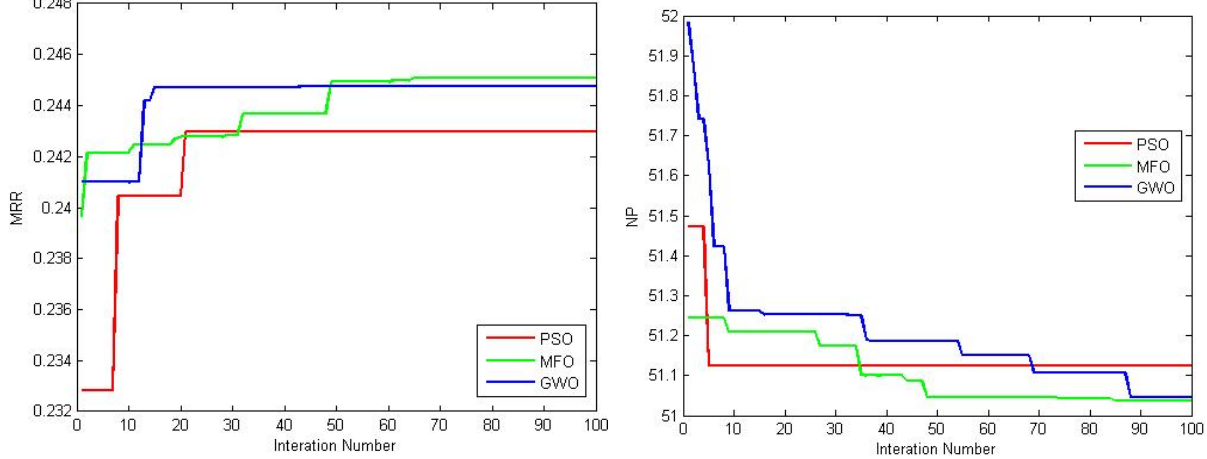
Figure 15. Comparison of convergence plots for various algorithms for MRR and NP. The optimum process parameters obtained by different meta-heuristics and the RSM are tabulated in Table 13. The convergence plot of the Pareto optimal solutions is shown in Figure 16, and the Pareto optimal set of process parameters out of 12 runs is presented in Table 14. Table 13. Optimum process parameters and the response values.